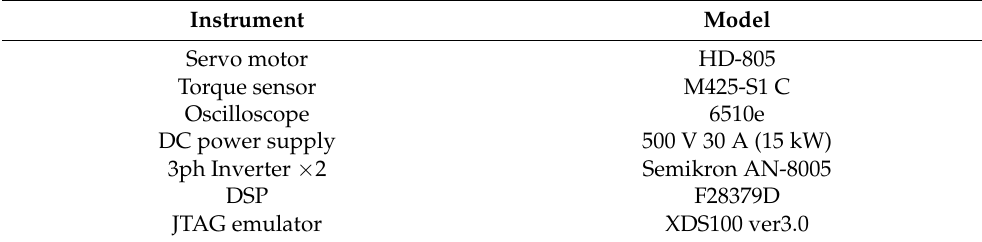
Table 8. The experimental